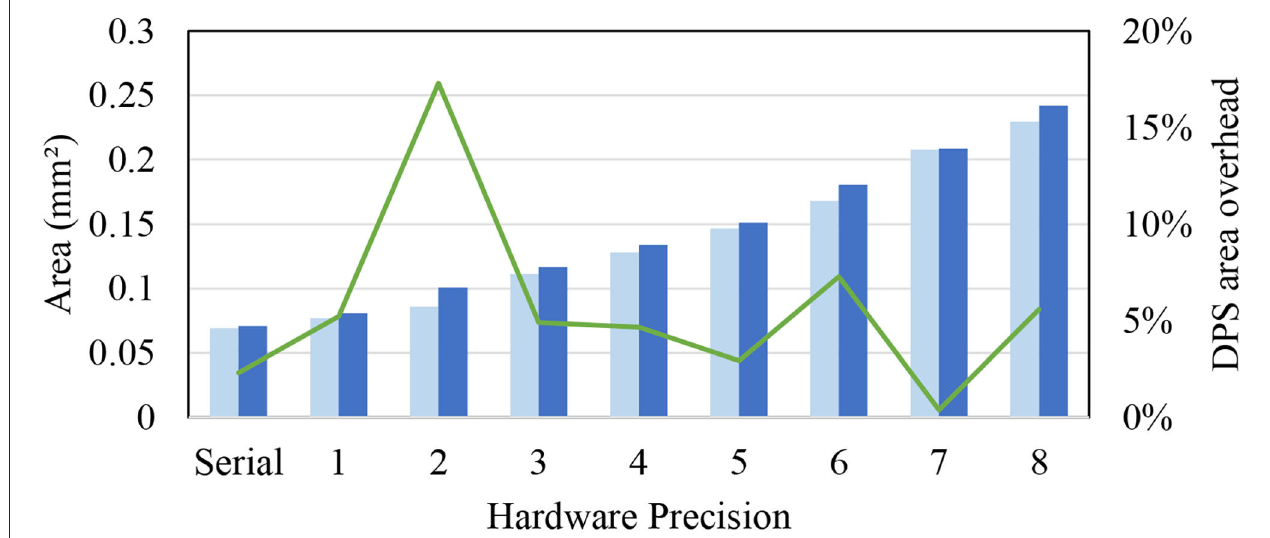
FIGURE 6 | Area overhead of dynamic precision scaling (DPS) SC-MVM vs.